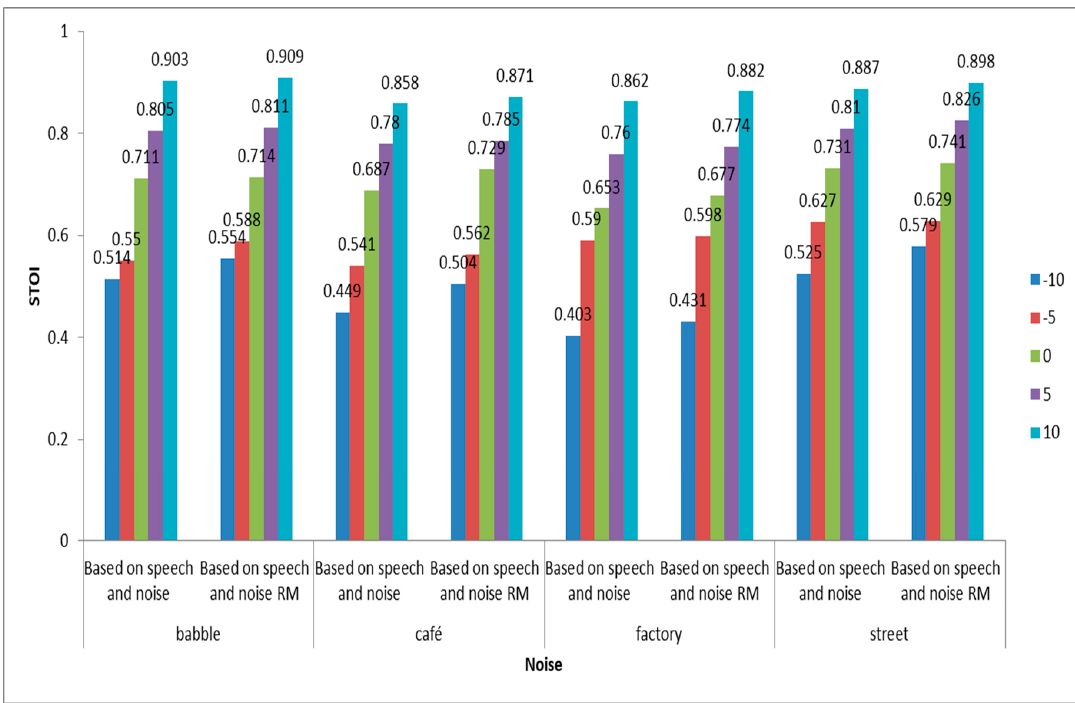
Figure 4. The effect of the speech and noise RM over speech and noise.